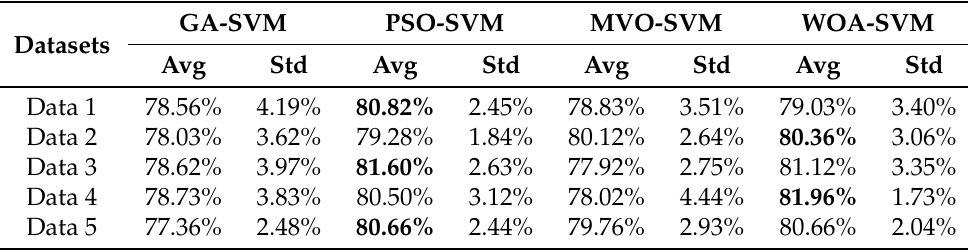
Table 10. F-measure results of GA-SVM, PSO-SVM, WOA-SVM, and MVO-SVM for First-rules